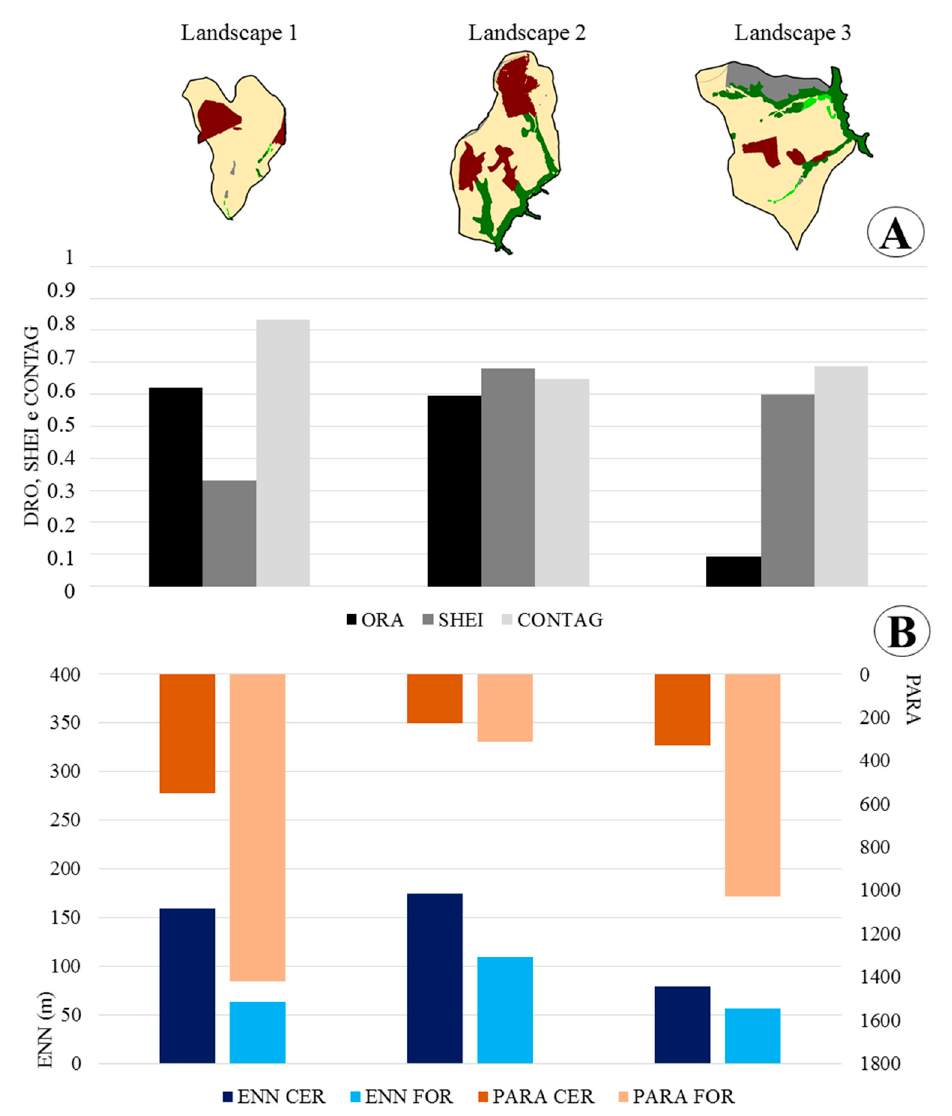
Figure 3. Structural measures of landscapes: ( A ) Optimal resource availability (ORA), Shannon evenness index (SHEI), and Contagion index (CONTAG); ( B ) mean Euclidean distance from the nearest neighbor (ENN_MN), Perimeter / area relationship (PARA), and the Number of patches (NP) for